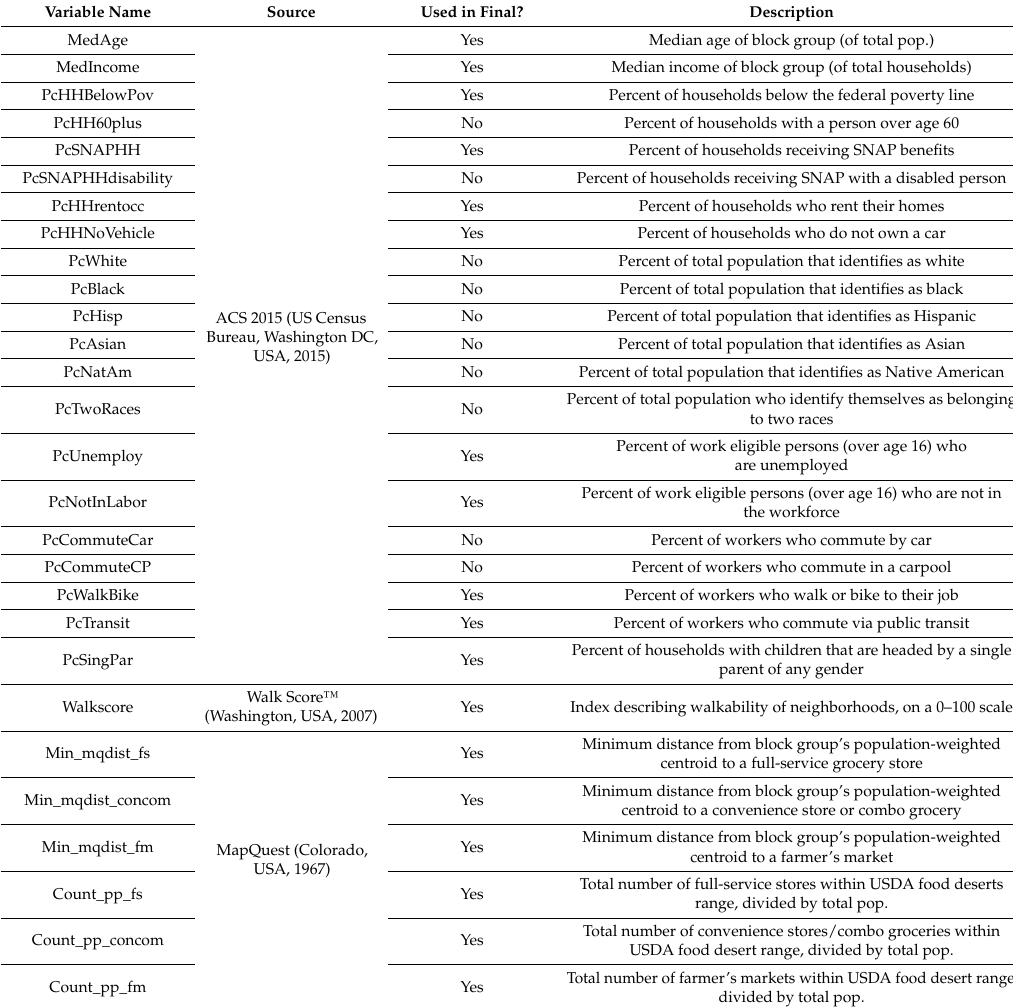
Table 1. Variables used in geodemographic segmentation